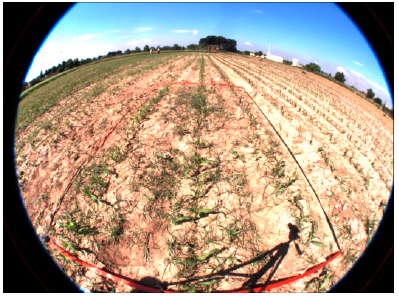
Figure 6. Imaging distortion caused by a sensor of type 2/3 ″ and a lens of 1/2 ″ .